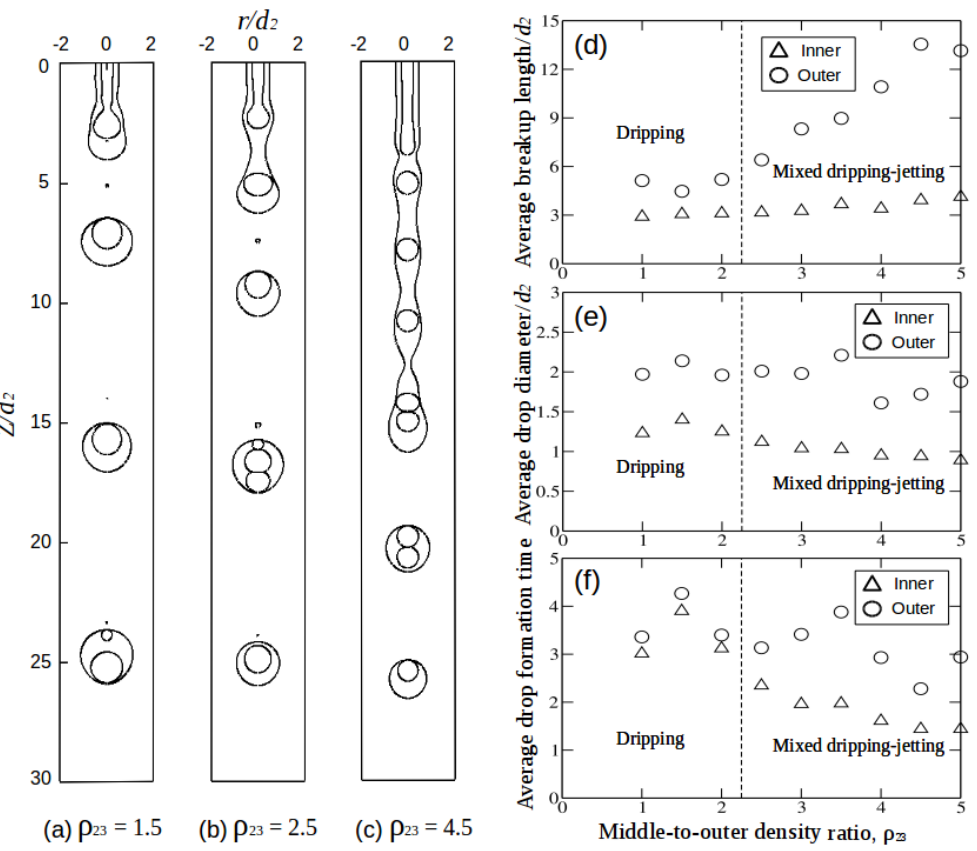
Figure 7. Snapshots of compound liquid jets for ( a ) ρ 23 = 1.5; ( b ) ρ 23 = 2.5 and ( c ) ρ 23 = 4.5. The rest of the parameters are ρ 13 = 1, µ 13 = 1 and µ 23 = 1. Graphs ( d – f ) represents the average breakup length, drop diameter and drop formation time for variable intermediate-to-outer density